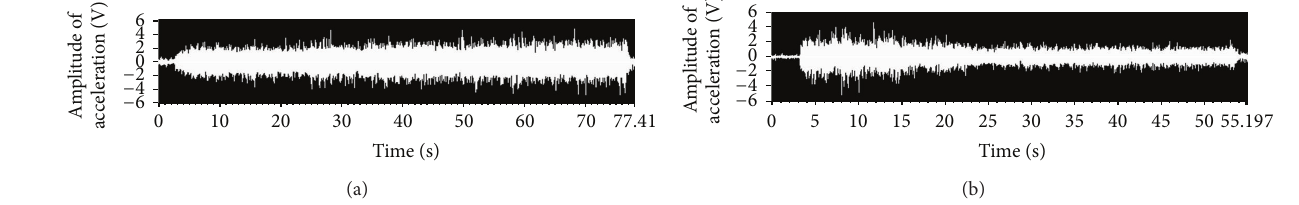
Figure 8: The time-domain signals of acceleration without current and 2 A current on each coil.